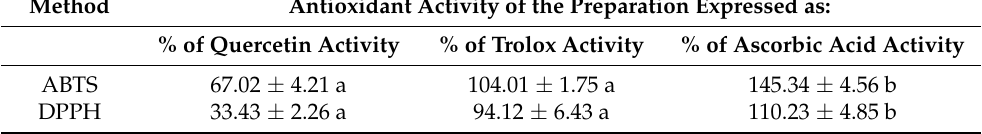
Figure 2. UV-vis spectrum of potassium quercetin derivative and quercetin. Q—quercetin methanol solution with a concentration of 0.1 mg/mL. Q + K—methanolic solution of potassium quercetin derivative with a concentration of 0.1 mg/mL.